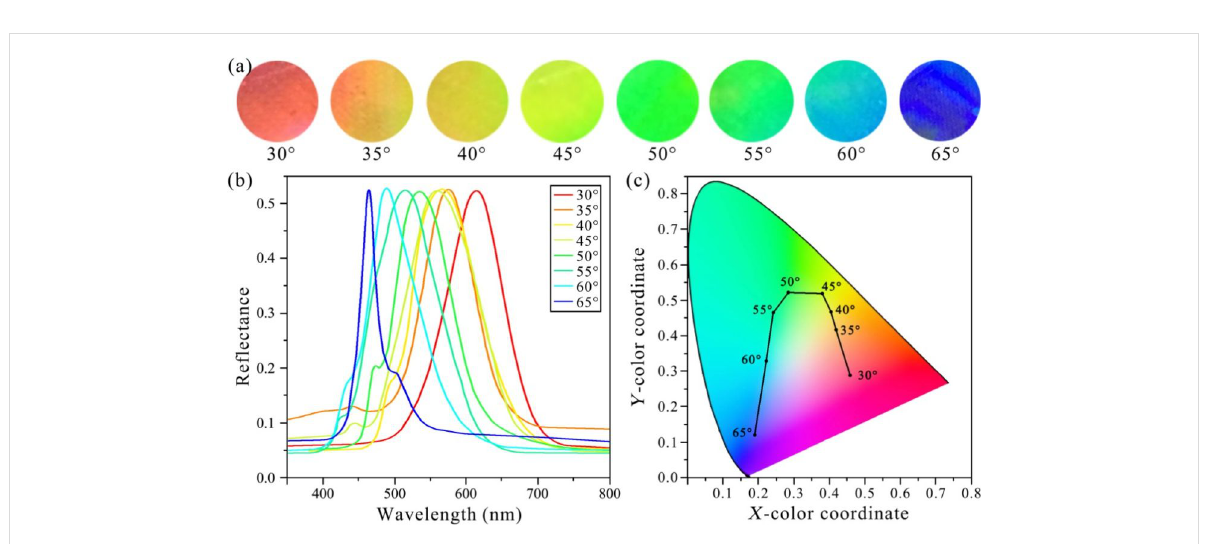
Figure 3: The relationship between horizontal observation angle and structural colors of the photonic crystal. (a) Color change of the photonic crystal as the horizontal observation angle is increasing. (b) Measured reflected spectra of white light for the photonic crystal under horizontal observation angles from 30° to 65°. (c) Measured peaks of the reflected spectra in the CIE 1931 xy chromaticity